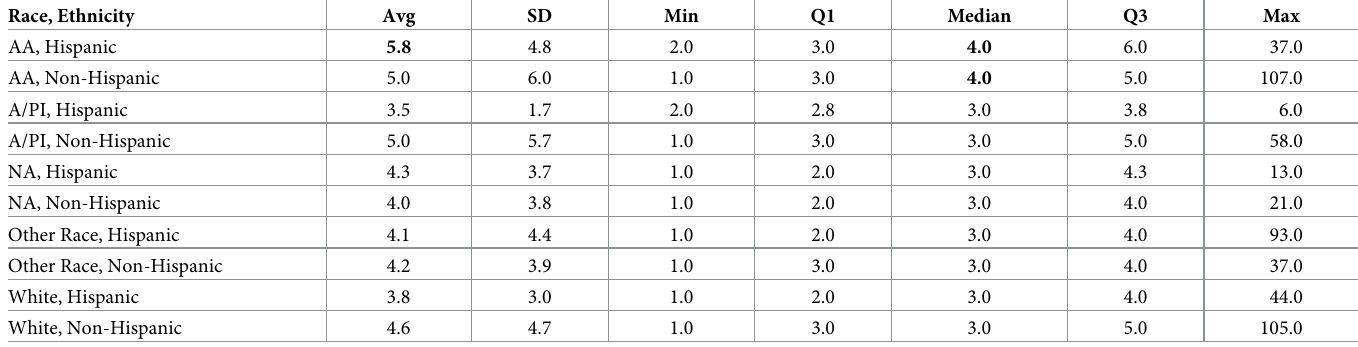
Table 5. Length of stay (days) by race/ethnicity for patients with PE for the Texas PUDF. We report the average (Avg), standard deviation (SD), minimum (Min), first quartile (Q1), median, third quartile (Q3), and maximum (Max) values. Race,